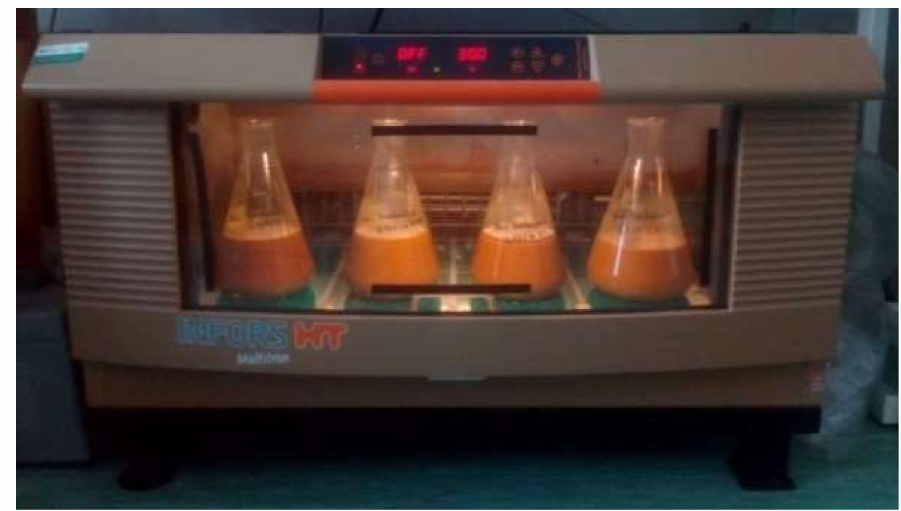
Figure 1. Bioleaching of samples of di ff erent particle sizes in an incubator shaker Multitron II.